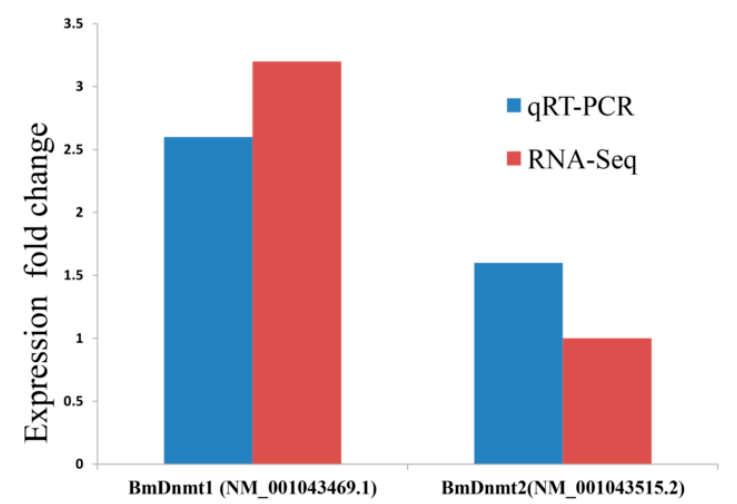
Figure 2. Analysis of methyltransferase expression. The expression fold change of BmDnmt1 and BmDnmt2 by qRT-PCR and RNA-seq, respectively, comparing diapause-terminated eggs with diapause-destined eggs.